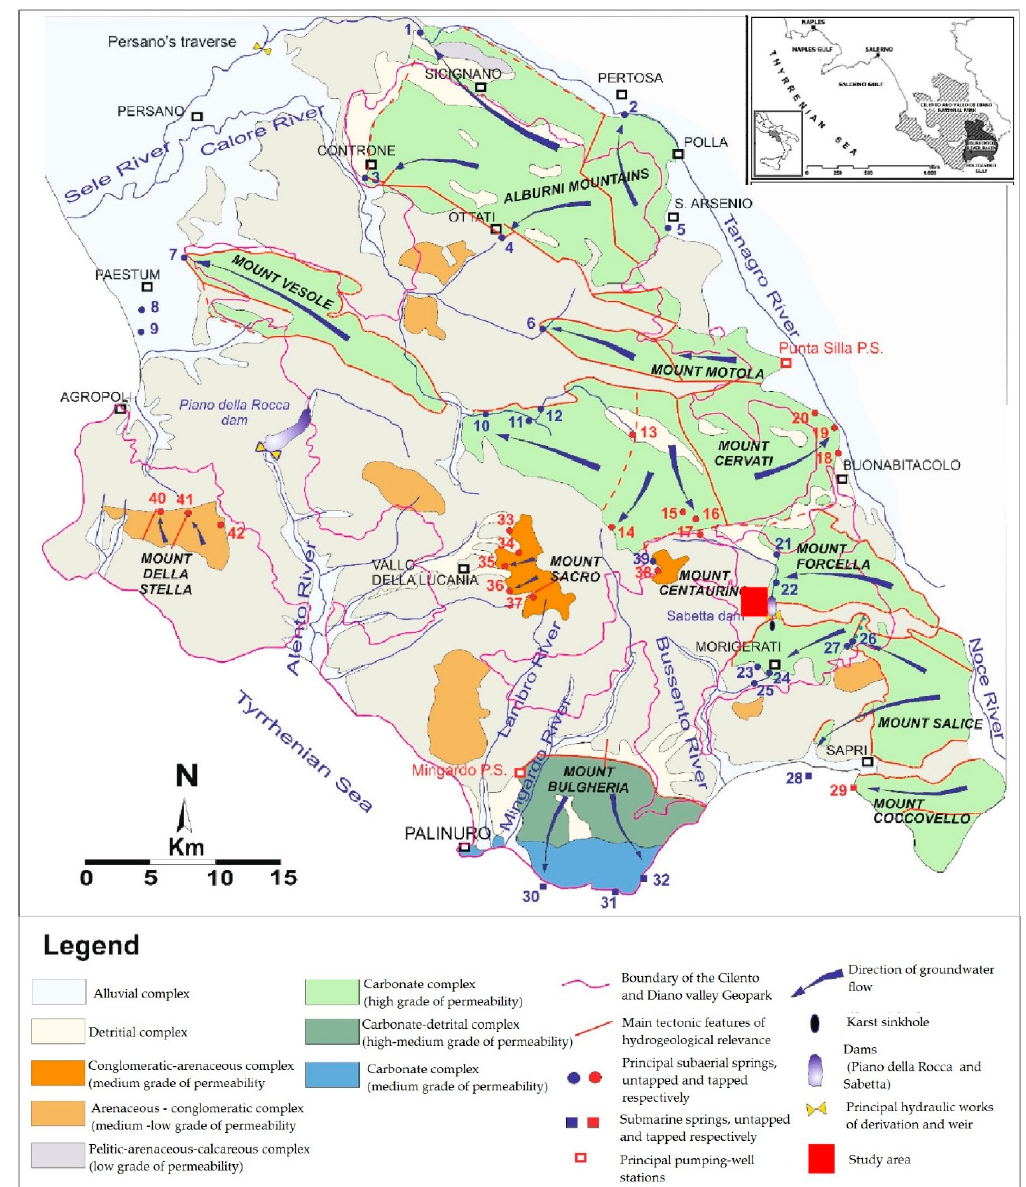
Figure 1. Hydrogeological map of the UNESCO Cilento Global Geopark (red square indicates the Ciciriello catchment location).